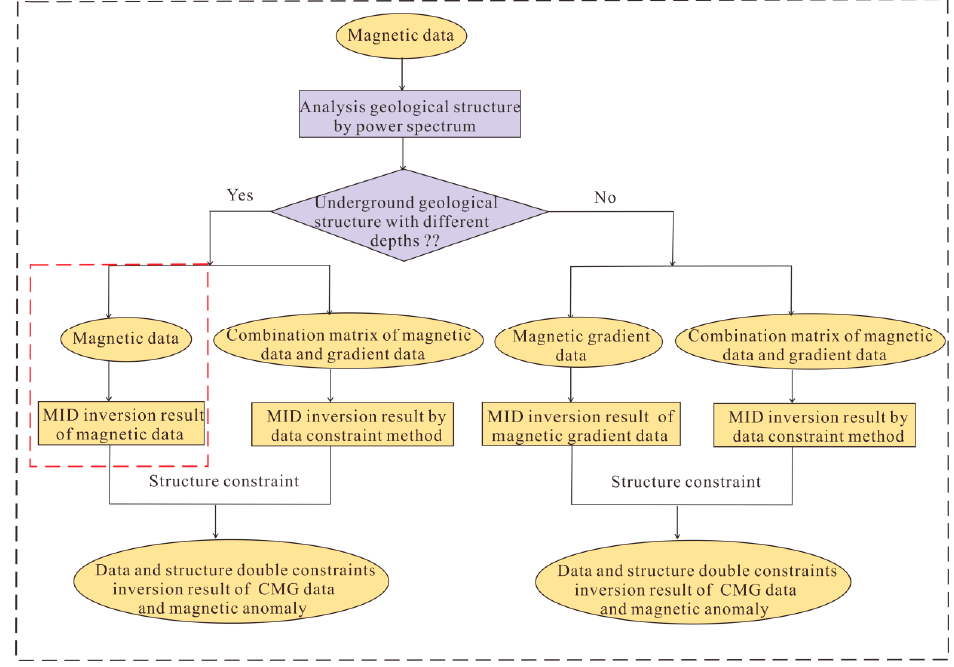
Figure 2. Data and structure double constraints inversion graph. (Published method in red box, proposed methods in black box). proposed methods in black